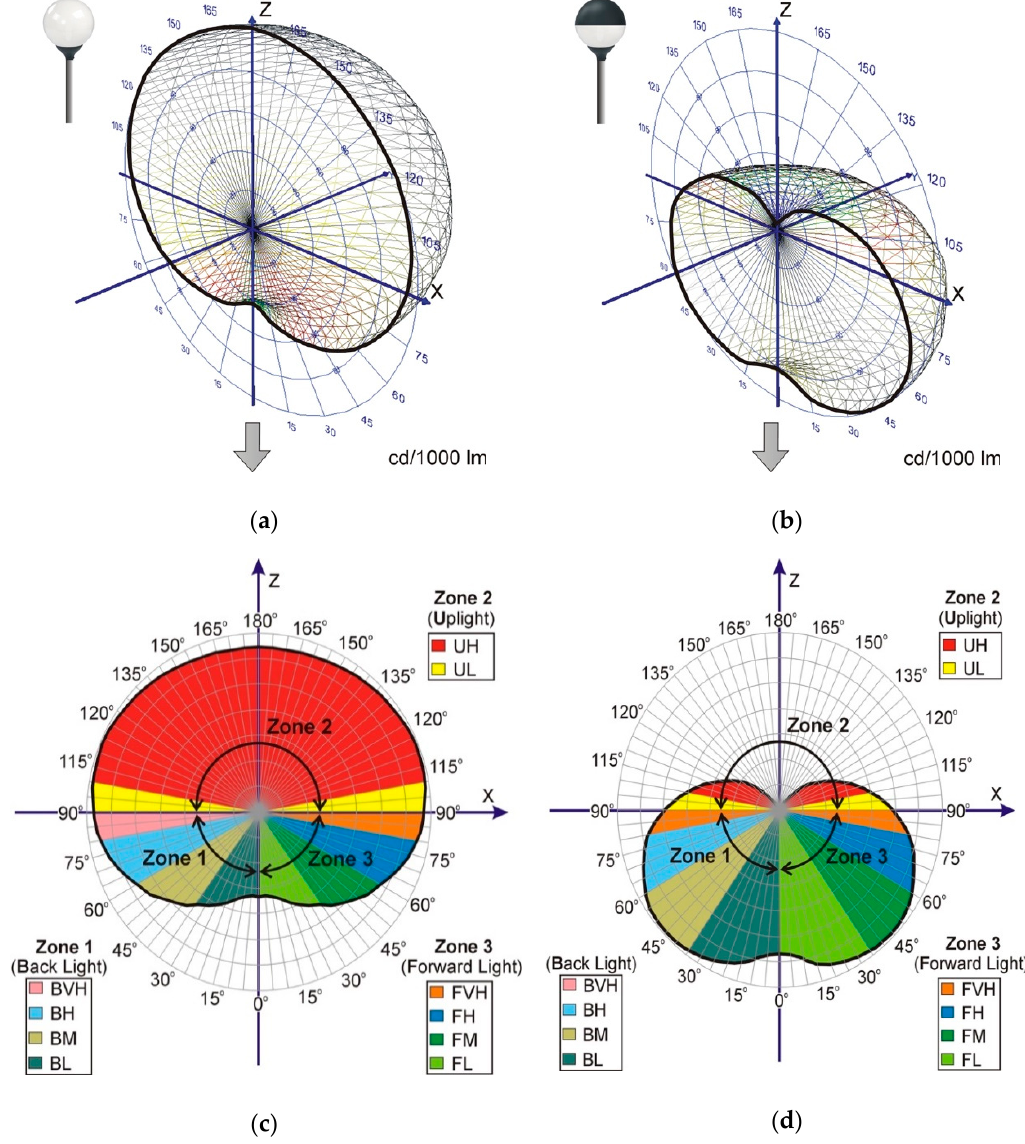
Figure 1. A graphic illustration of the opal-sphere-type luminaire with the method of light distribution: ( a , b ) a photometric solid, and ( c , d ) a luminosity graph with marked angle zones classified per the Backlight, Uplight, and Glare (BUG) classification system for outdoor luminaires.